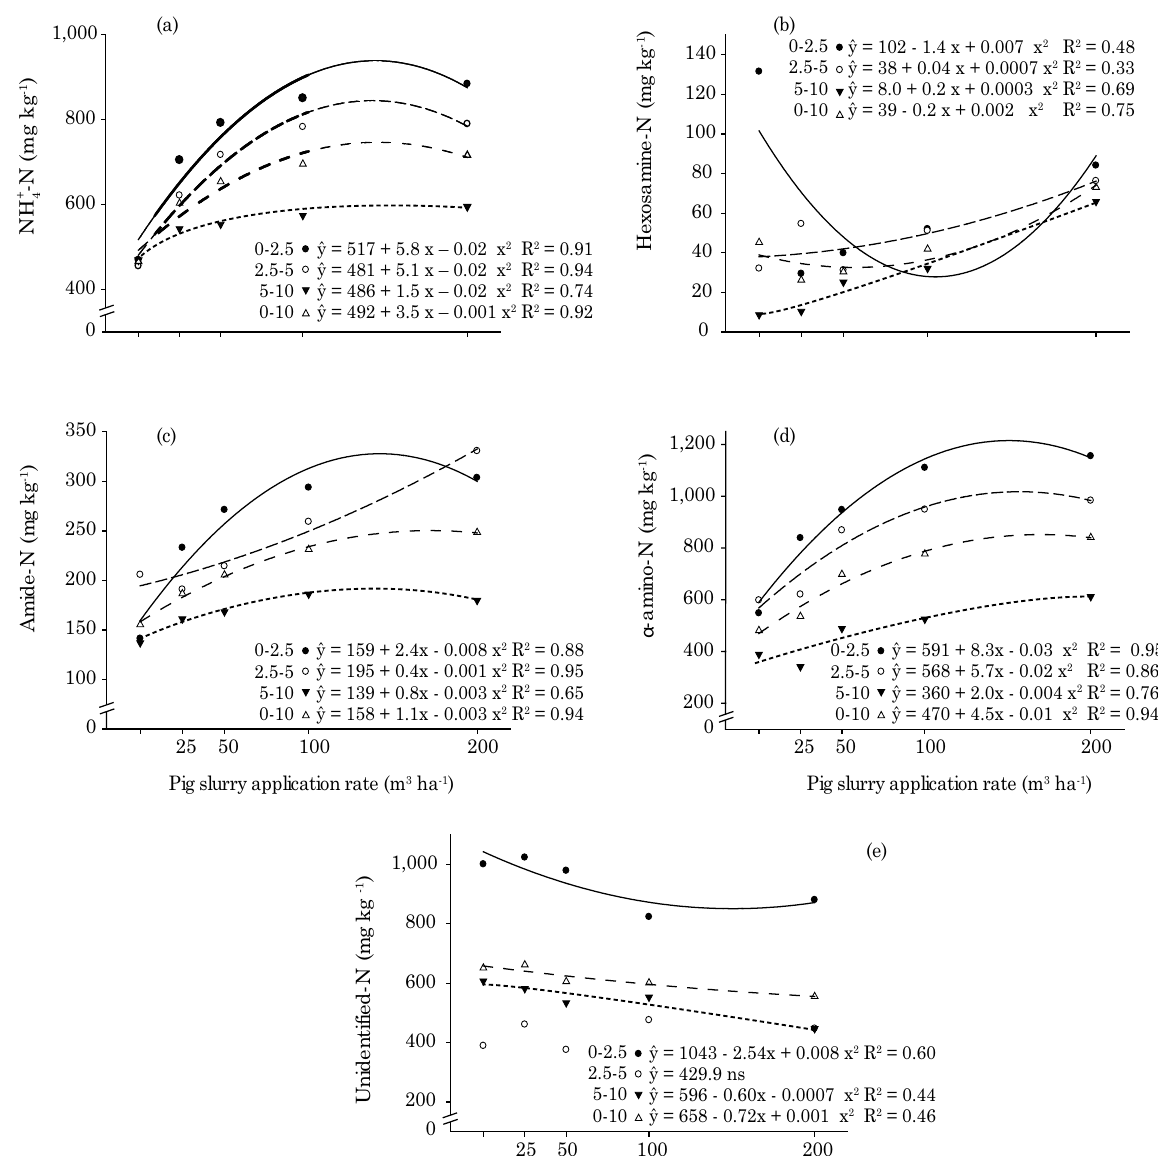
Figure 2. Contents of (a) nH + 4 -N, (b) hexosamine-N, (c) amide-N, (d) α-amino-N, and (e) unidentified-N in the 0-10 cm layer in a latossolo Vermelho distroférrico (Typic Hapludox) subjected to 10 years of annual fertilization of pig slurry at the rates of 0, 25, 50, 100, and 200 m -3 ha -1 .